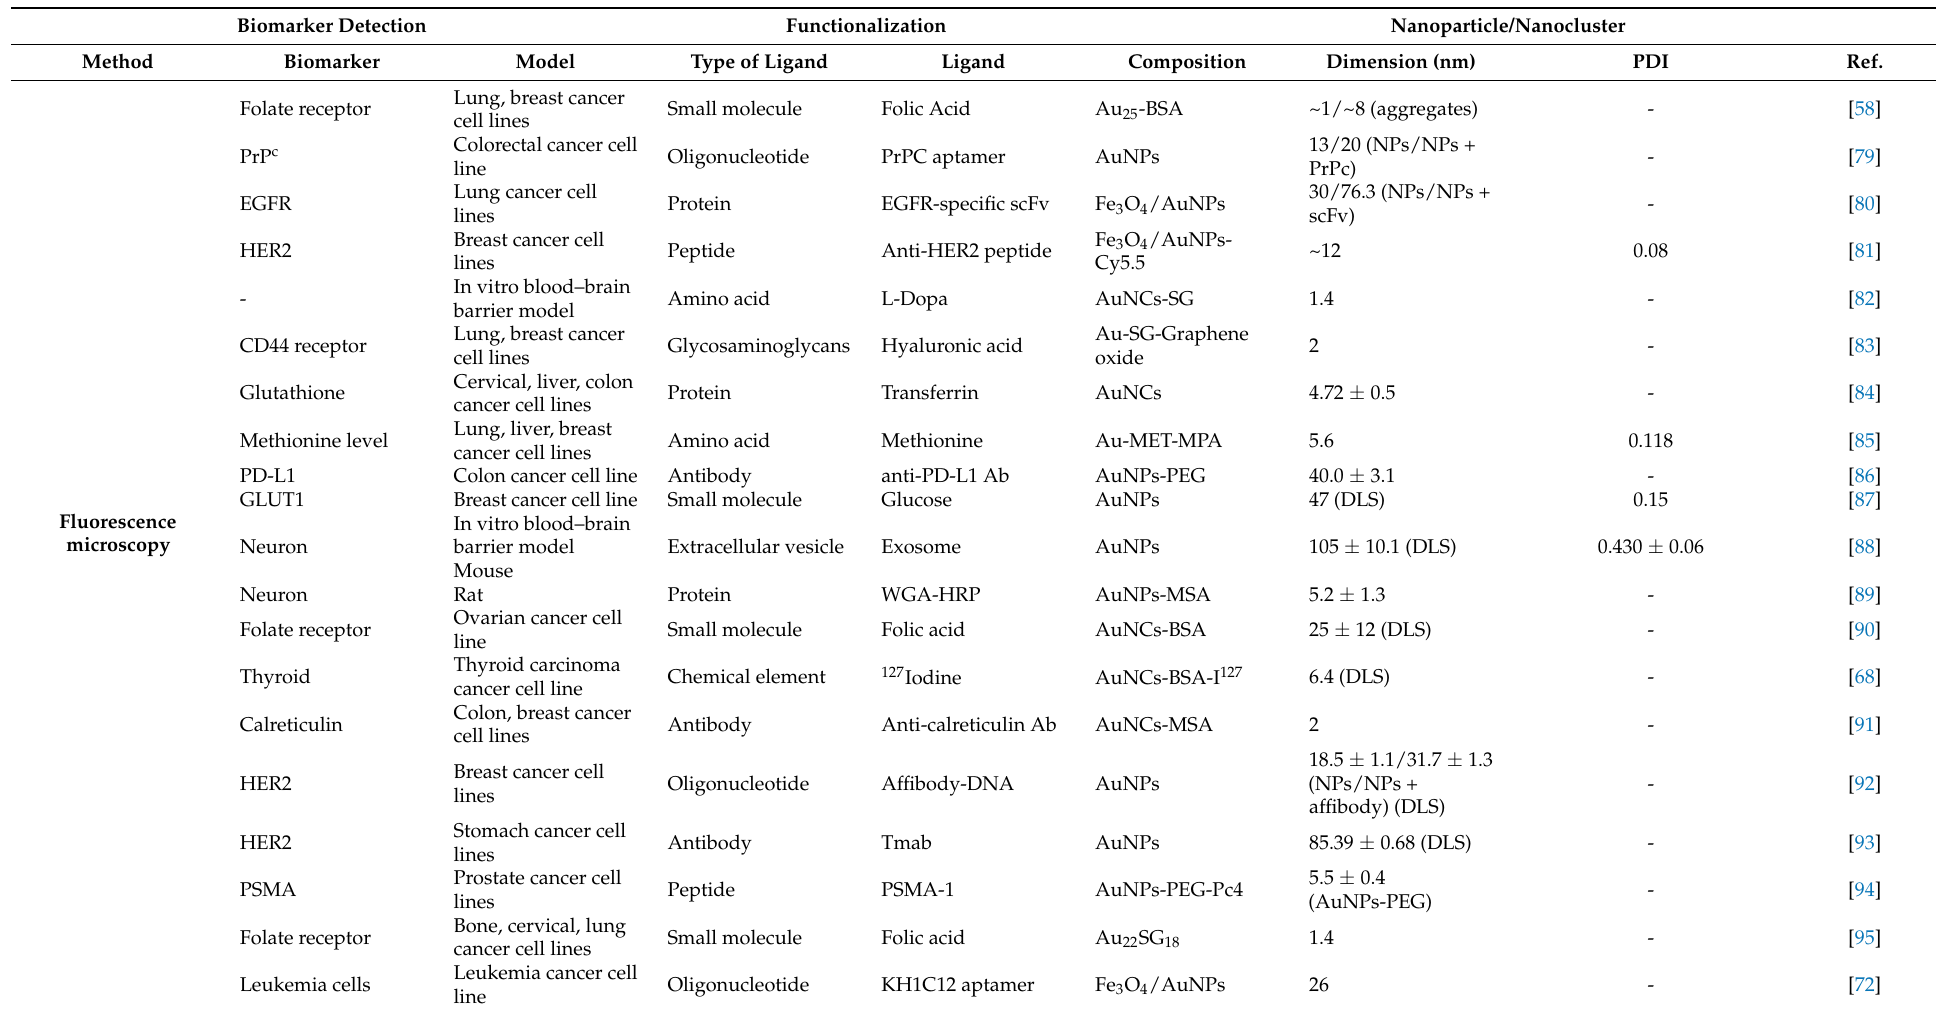
Table 2. Examples of cancer biomarker detection by different types of metallic